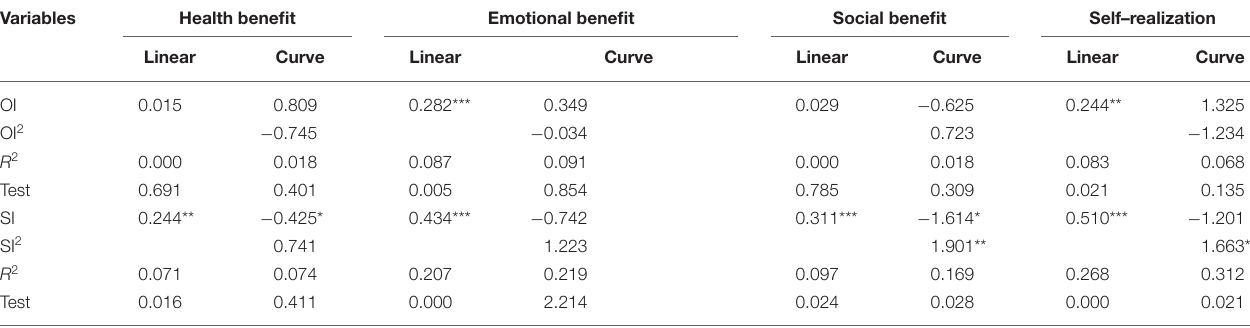
linear models (9.7 and 26.8%). In addition, both the signs of the square item coefficients r of the two curve models were positive, indicating that the opening of the parabola was upward. It could be seen that the degree of personal